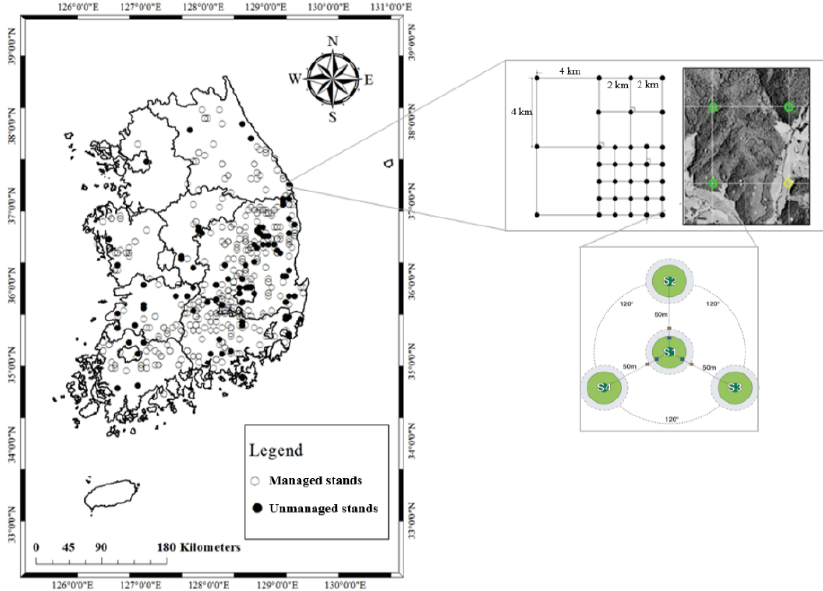
Figure 1. Geographical distribution of study sites for Pinus densiflora stands in South Korea.